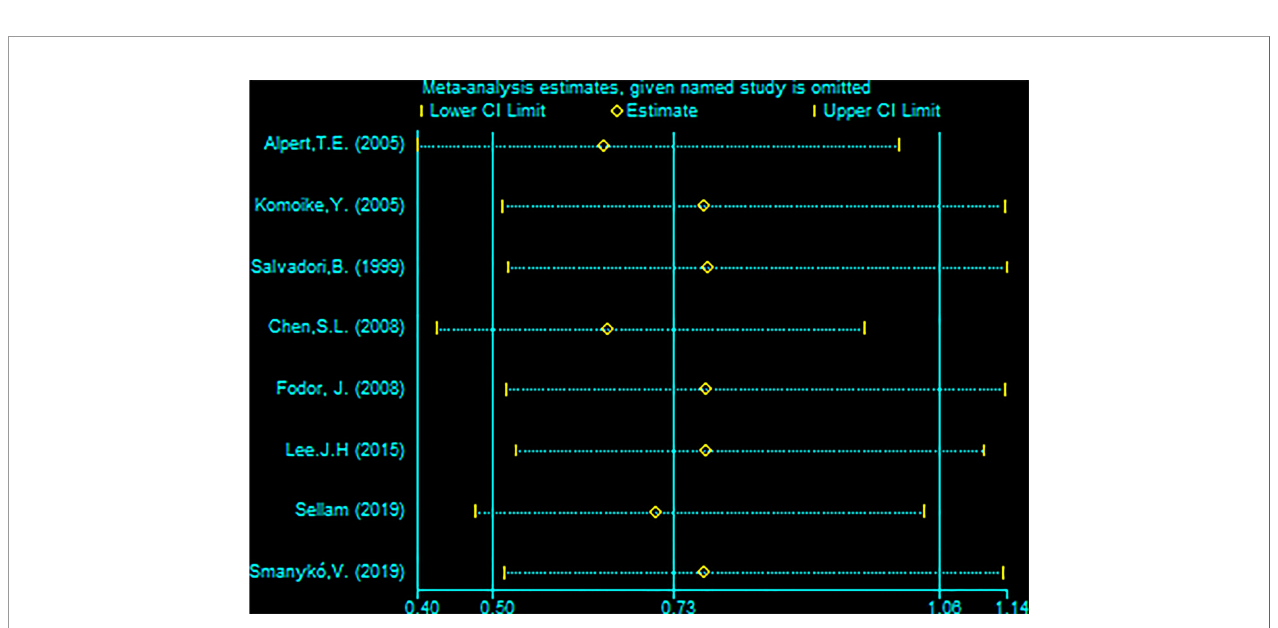
FIGURE 9 | Sensitivity analysis of meta-analysis of overall survival (OS) by the method omitting one